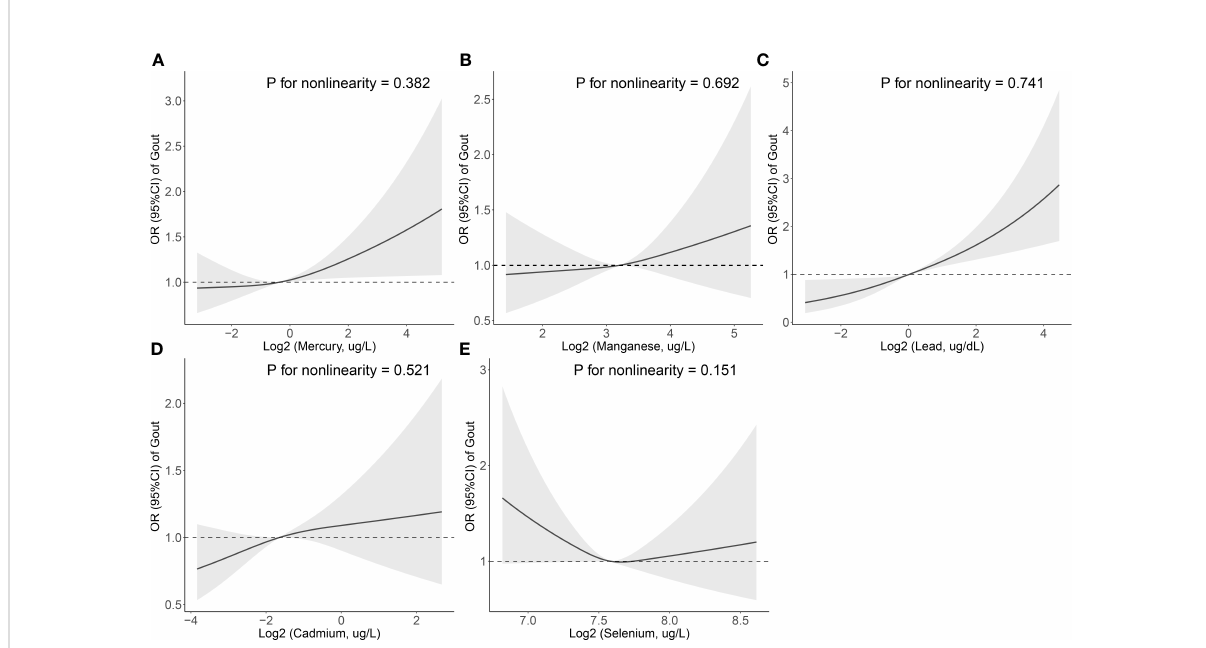
FIGURE 2 Association between the blood metal ( A : Mercury, B : Manganese, C : Lead, D : Cadmium, and E : Selenium) levels and the prevalence of gout. The odds ratio of gout from a restricted cubic spline logistic regression model with knots at the 10 th , 50 th , and 90 th percentiles. Model was adjusted for age, sex, education level, race, poverty, smoker, alcohol user, energy intake levels, sedentary time, BMI, total cholesterol, high-density lipoprotein cholesterol, eGFR, urinary creatinine, urinary albumin, diuretics, beta-blockers, diabetes, and